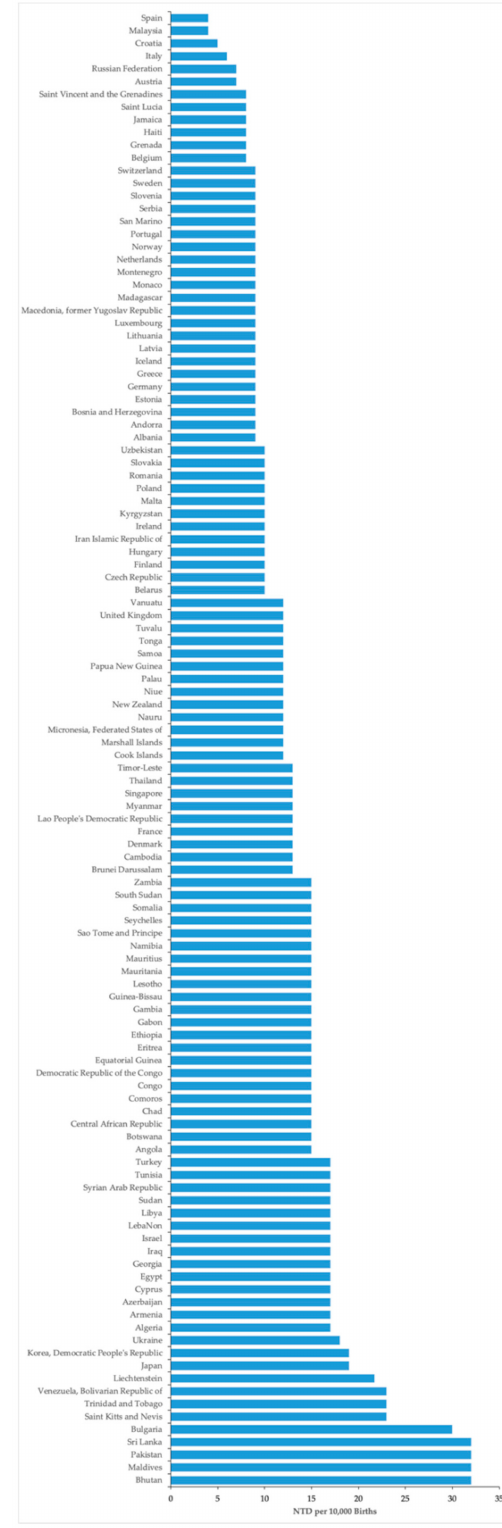
Figure 4. Prevalence of NTDs in the absence of national folic acid fortification. The number of NTDs per 10,000 births was plotted (blue bars) versus country ( n =